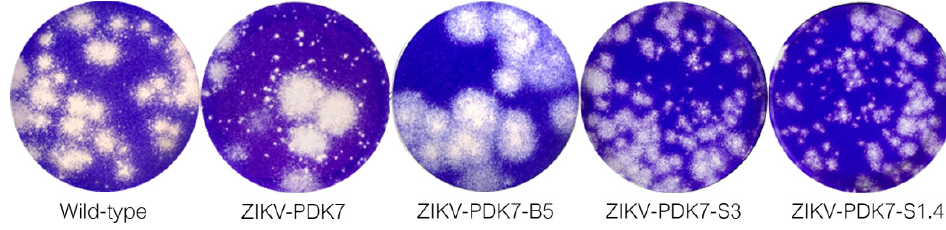
ZIKV-PDK7-S1.4 variants. Plaque morphology of ZIKV variants were observed by avicel-based plaque assays in Vero cells at 5 dpi. ZIKV-CVD_06-020, an Asian wild-type ZIKV, contains mixed plaque variants with plaques diameter ranging from 0.1 to 0.5 mm. ZIKV-PDK7—a wild-type